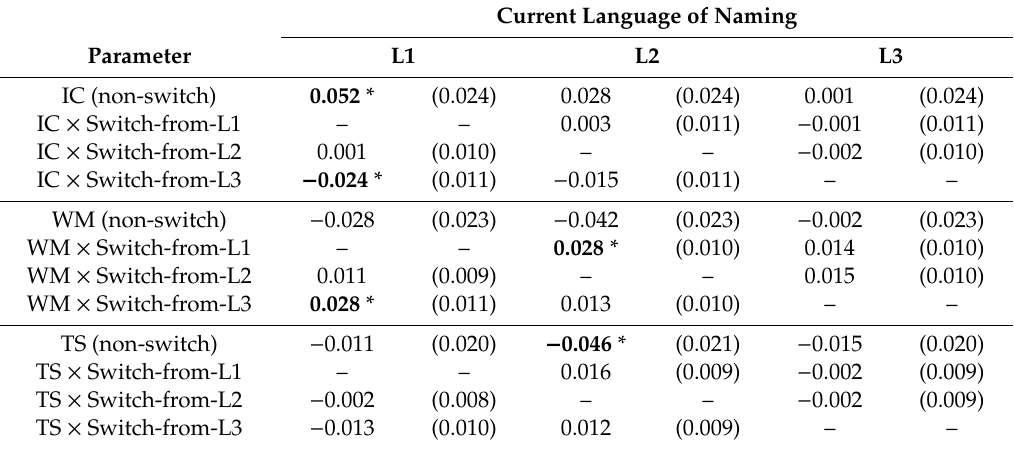
Table 4. Model parameters and standard errors (SEs) for EF predictors in non-switch and switch conditions for the three languages of production.